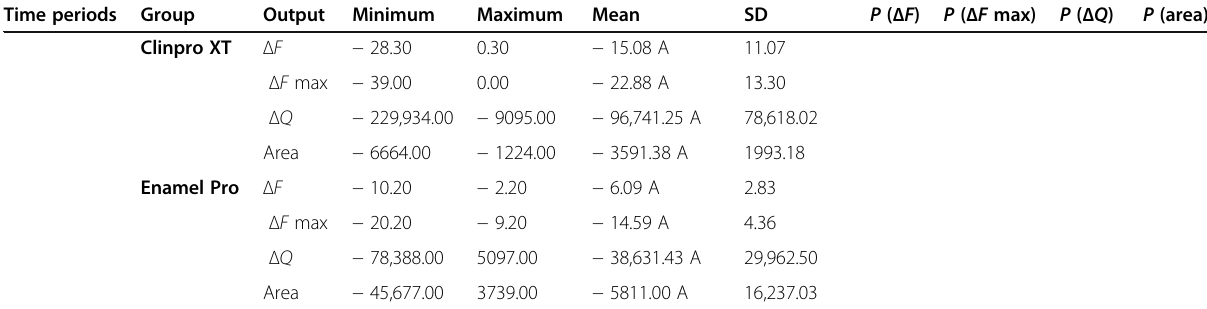
Table 3 Intergroup comparisons of the QLF measurements ’ changes between different time points (Continued) Time periods